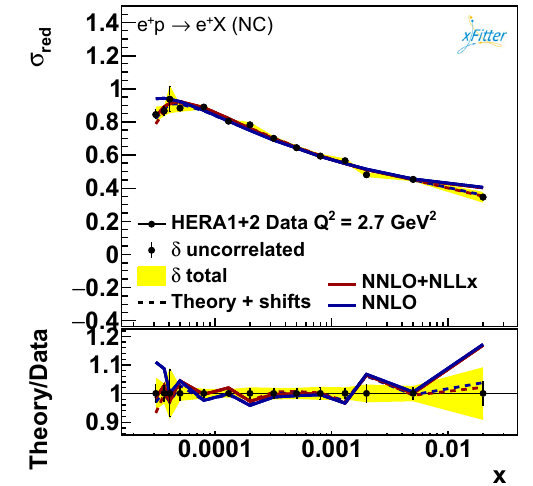
Fig. 10 The HERA NC E p = 920 GeV data at Q 2 = 2 . 7GeV 2 compared to the fits with and without ln ( 1 / x ) resummation including this